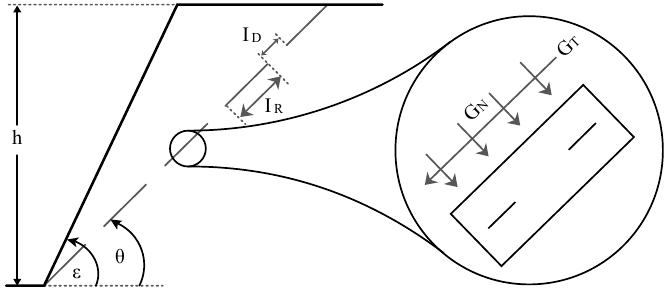
Figure 12. Local stress diagram of locked section.